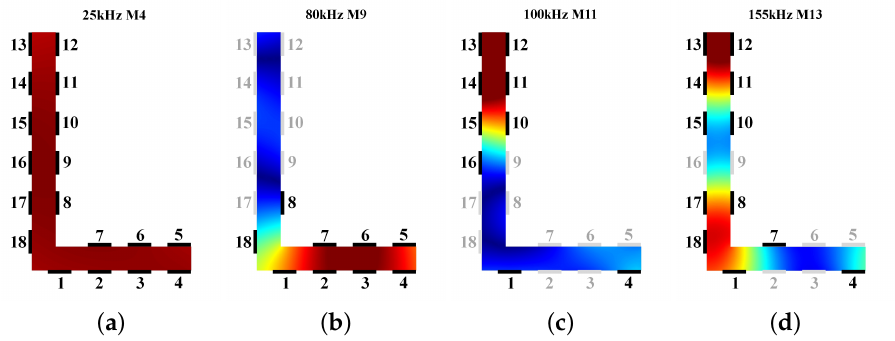
Figure 8. Optimized excitation combinations (black ones): ( a ) 25 kHz M4, ( b ) 80 kHz M9, ( c ) 100 kHz M11, ( d ) 155 kHz